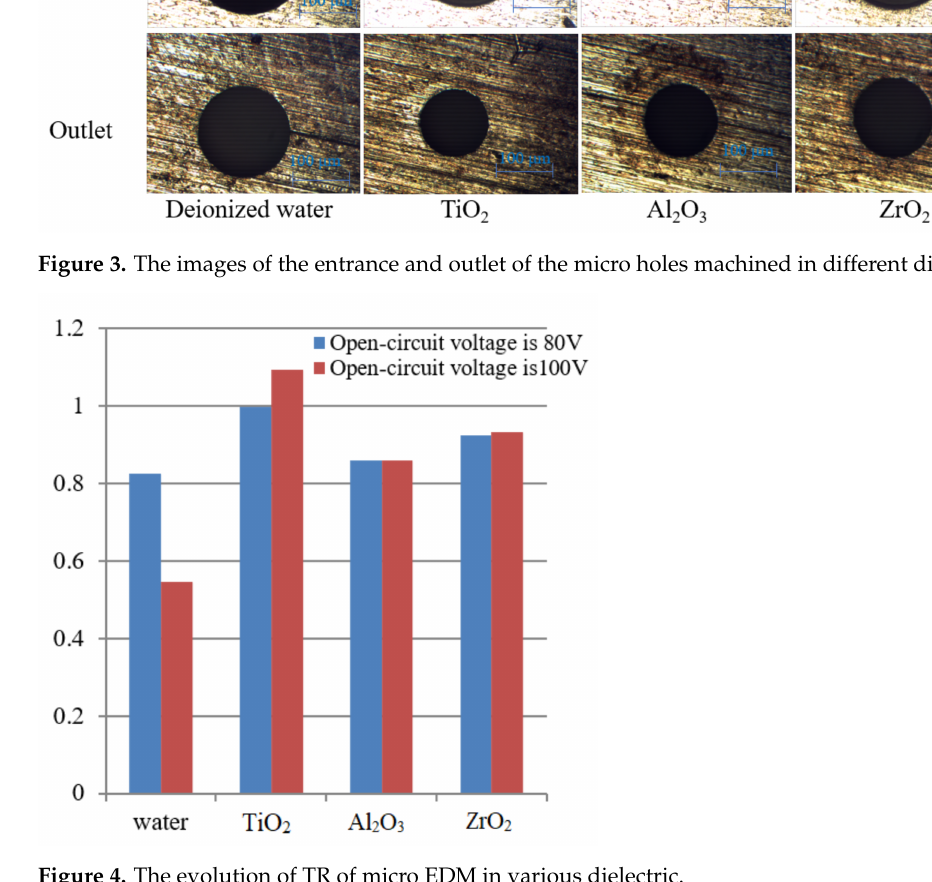
Figure 4. The evolution of TR of micro EDM in various